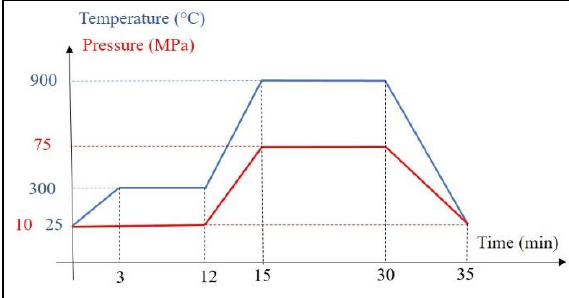
Figure 3. SPS conditions for TiO 2 powder embedded Ti6Al4V lattice structure.